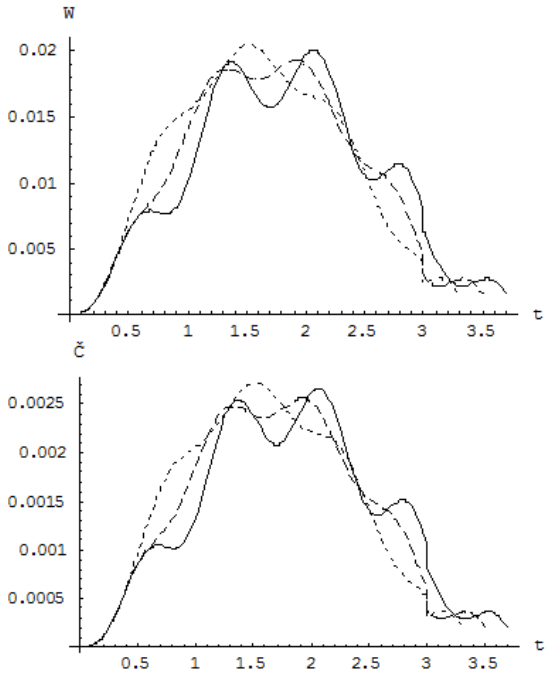
Figure 30: The influence of the vehicle length for R = 150 m, υ = 30 m/s, e H = 3.00 m, e V = 1.20 m and d = 7 m ( __ ), d = 5 m ( _ _ ), and d = 3 m (- - - ).